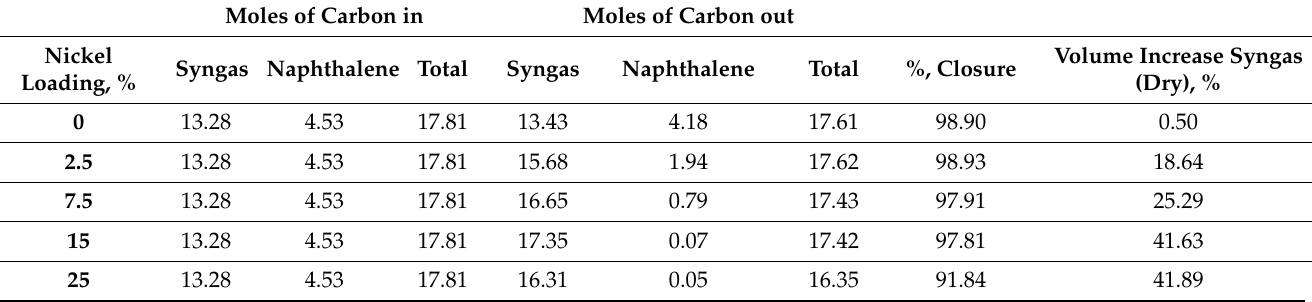
Table 5. Carbon balance: influence of nickel loading on naphthalene conversion (T—750 ◦ C, GHSV—12,800 h − 1 , S/C—5, naphthalene loading—58 g/Nm 3